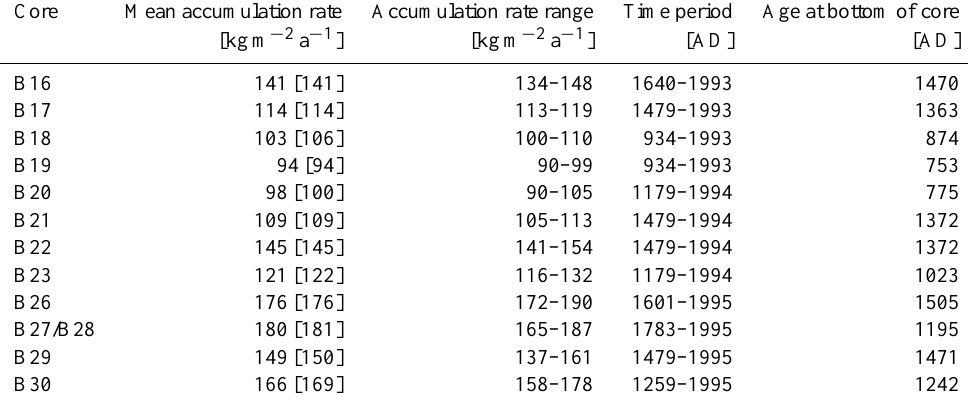
Table 3. Resulting mean accumulation rates (from the surface to the deepest volcanic horizon and in brackets for their common time frame (AD1505–1953)) for each NGT drill site, the lowest and highest rate within the whole core length, the time period from surface to the deepest volcanic horizon, and the age at the bottom of the ice core calculated by extrapolation of the deepest calculated accumulation rate.